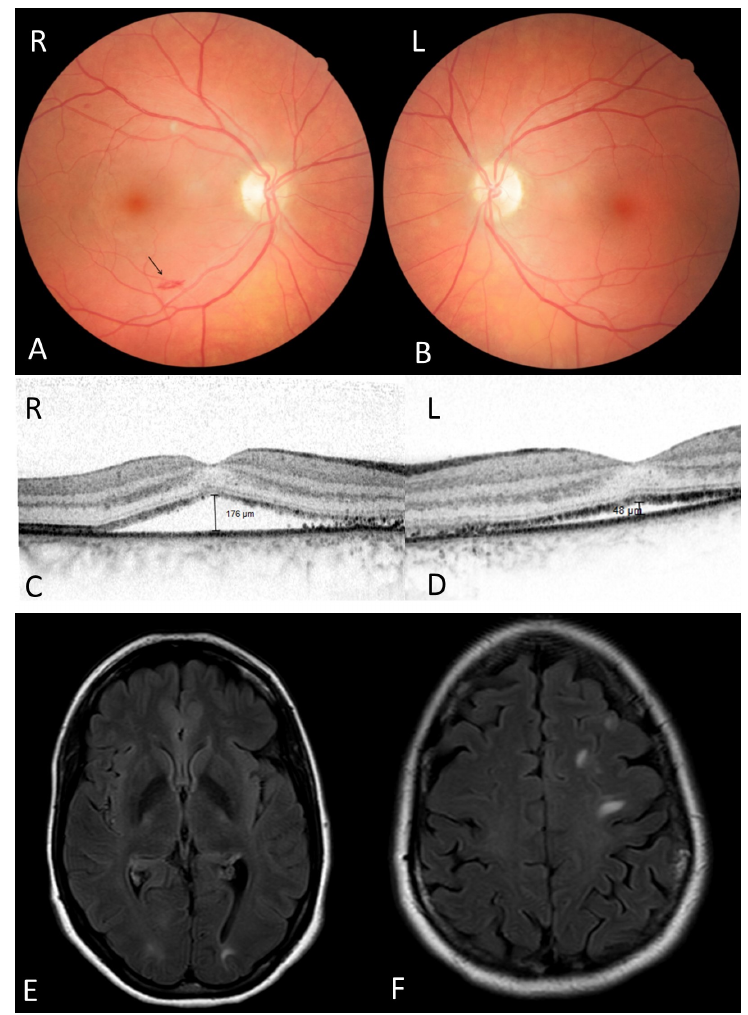
Figure 2: Retinal and radiological changes in PRES. A, B: Funduscopic image of patient 2 with PRES at baseline showing a small bleeding (arrow) in the right eye. C, D: OCT of patient 2 with PRES at baseline showing bilateral subretinal fluid. E: MRI image of patient 2 with PRES showing hyperintensity in the temporo-parietal region. F: MRI image showing hyperintensity in the occipital